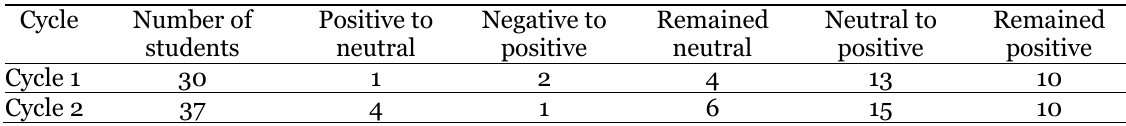
Attitude Change Towards the Playful Approach Adopted in the Course Cycle Number of Positive to Negative to Remained students neutral positive Cycle 1